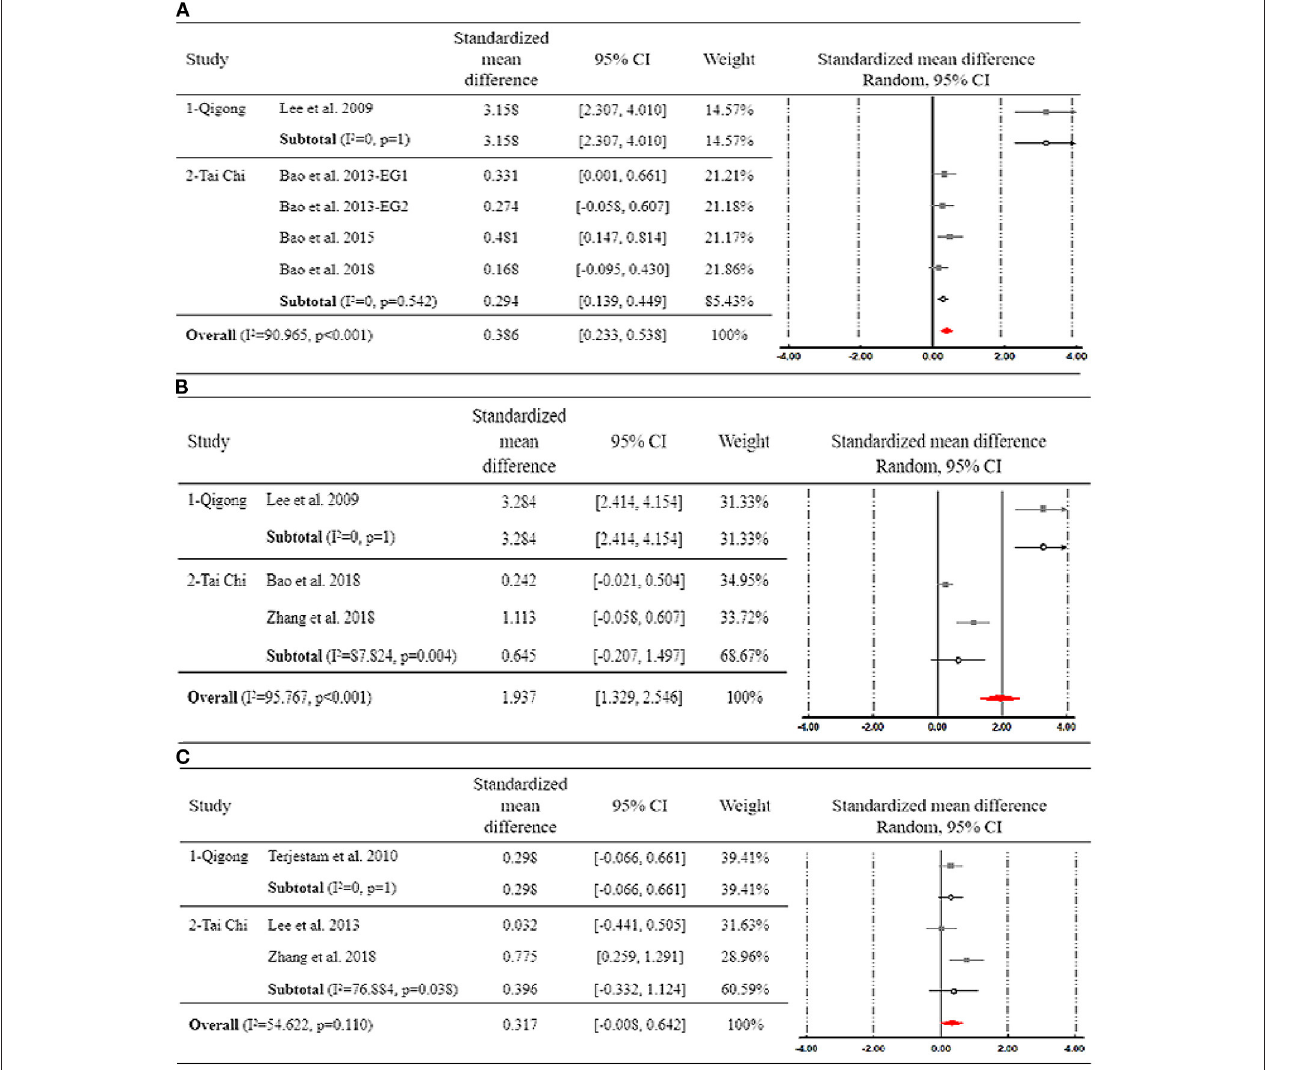
(SMD = 0.104, 95 CI% [ − 0.245, 0.452]), with a low degree of heterogeneity ( I ² = 22.555%) ( Figure 3B